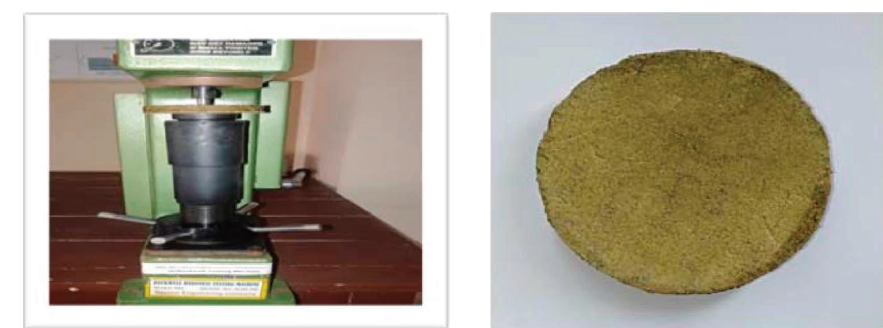
Figure 3: Hardness test setup. Table 1: Tensile test result of rice bran PLA